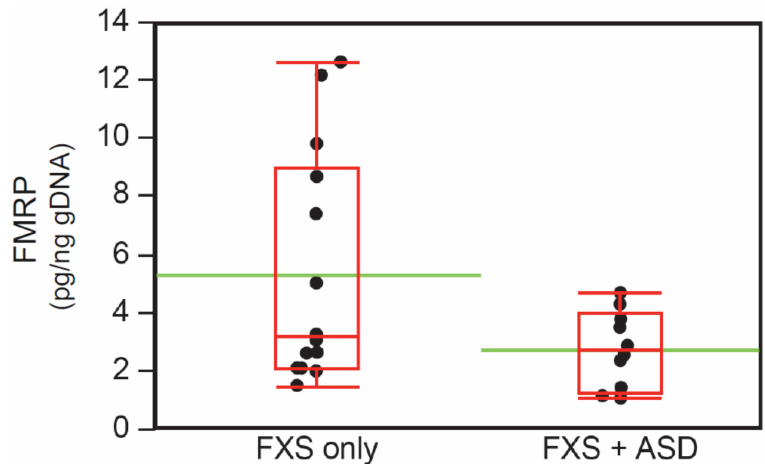
Figure 6. FMRP levels in whole blood specimens from males with FXS with and without ASD. qFMRP measurements showed significantly higher levels in the FXS-only group than in those with FXS + ASD ( p = 0.04, Welch’s t -test). The box plots outline median and percentiles 25 and 75 for each group, while the green line represents the mean for each